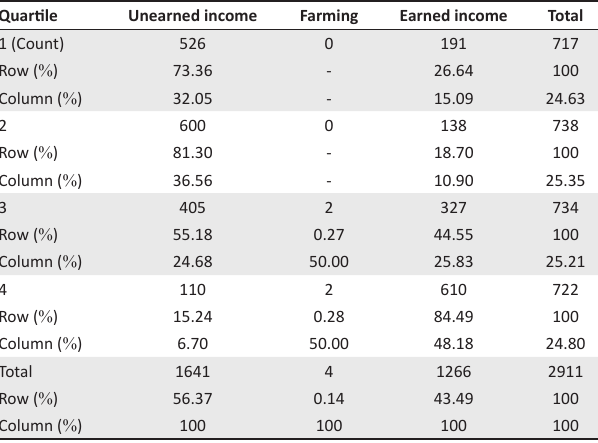
TABLE 5: Sources of income. Quartile